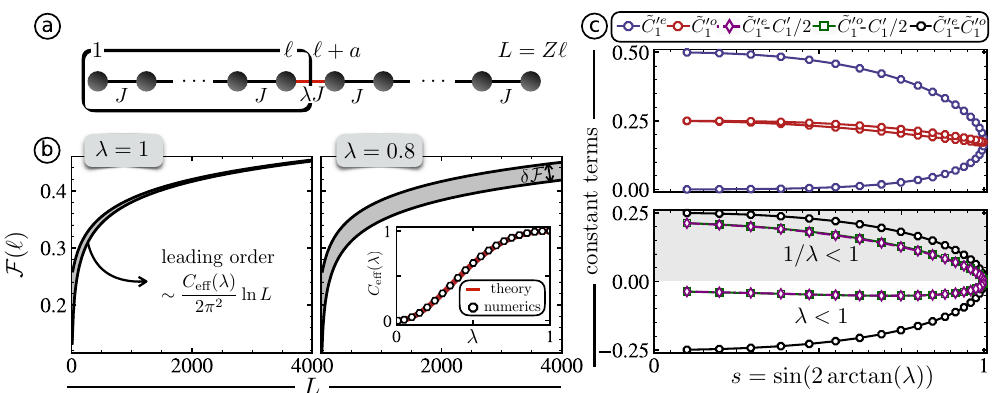
Figure 3: Charge fluctuations in a tight binding system with a single impurity link and open boundaries. a (cid:13) Illustration of the model. An impurity is placed between sites + 1, respectively), with impurity at (cid:96) and (cid:96) + a (correpsonding to site indices j and j 0 0 hopping λ J . The total system size is set to be L = Z (cid:96) , where we choose Z = 10. b (cid:13) Fluctuations in subsystem A (circled region in a (cid:13) ) for λ = 1 (left) and λ = 0.8 (right). ( 1 ) are observed, illustrated by the gray For λ < 1, non-decaying parity effects of O background. The inset shows the predicted values of C ( λ ) , cf. Eq. (27), compared to the numerically extracted leading order behavior for varying impurity strength. c (cid:13) Even component ˜ C (cid:48) e (upper panel, blue circles) and odd component ˜ C (cid:48) o (upper 1 1 − ˜ C (cid:48) o panel, red circles) of the charge fluctuations, the corresponding difference ˜ C (cid:48) e 1 1 / 2 (lower panel, (lower panel, black circles) and the isolated boundary parts ˜ C (cid:48) e / o − C (cid:48) 1 ( λ ) , ˜ C (cid:48) o ( λ ) and C (cid:48) ( λ ) / 2 are purple diamonds and green squares) for varying λ . ˜ C (cid:48) e 1 1 1 obtained by numerically fitting the data to Eq. (32) for open and Eq. (35) for periodic boundary